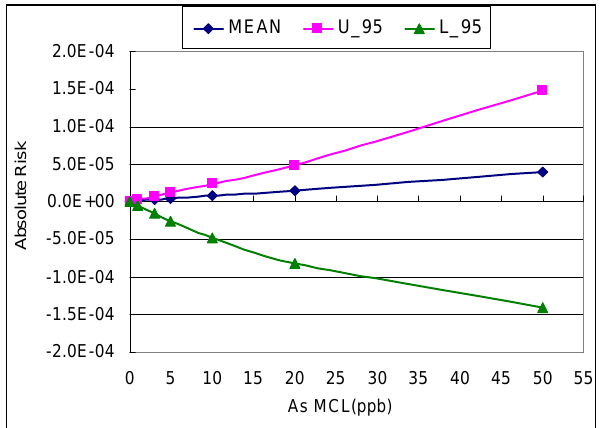
Figure 5: Absolute Risk of Bladder Cancer at different proposed MCLs (Maximum Contaminant Levels) from meta- analysis. (Mean: the best estimation of slope factor, U_95: the upper bound estimation of slope factor) Table 3: Risk of bladder cancer at different MCLs MCL (ppb)